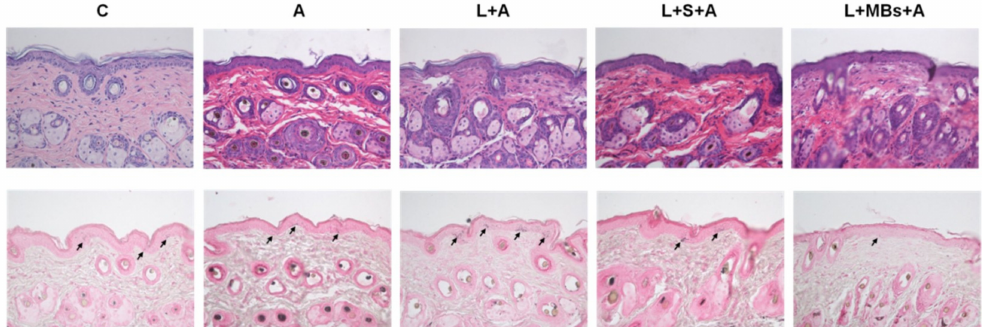
Figure 10. Histology images (HE, ( upper row ); Fontana-Masson silver nitrate, ( lower row )) for groups C, A, L + A, L + S + A, and L + MBs + A at day 20. Arrows indicate melanocytes in the basal layer of the